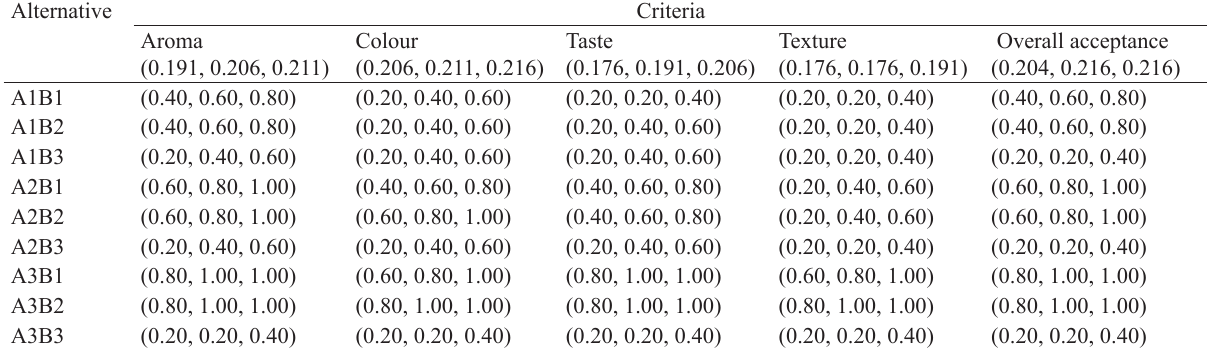
Table 10 Matrix of TFN scale normalisation